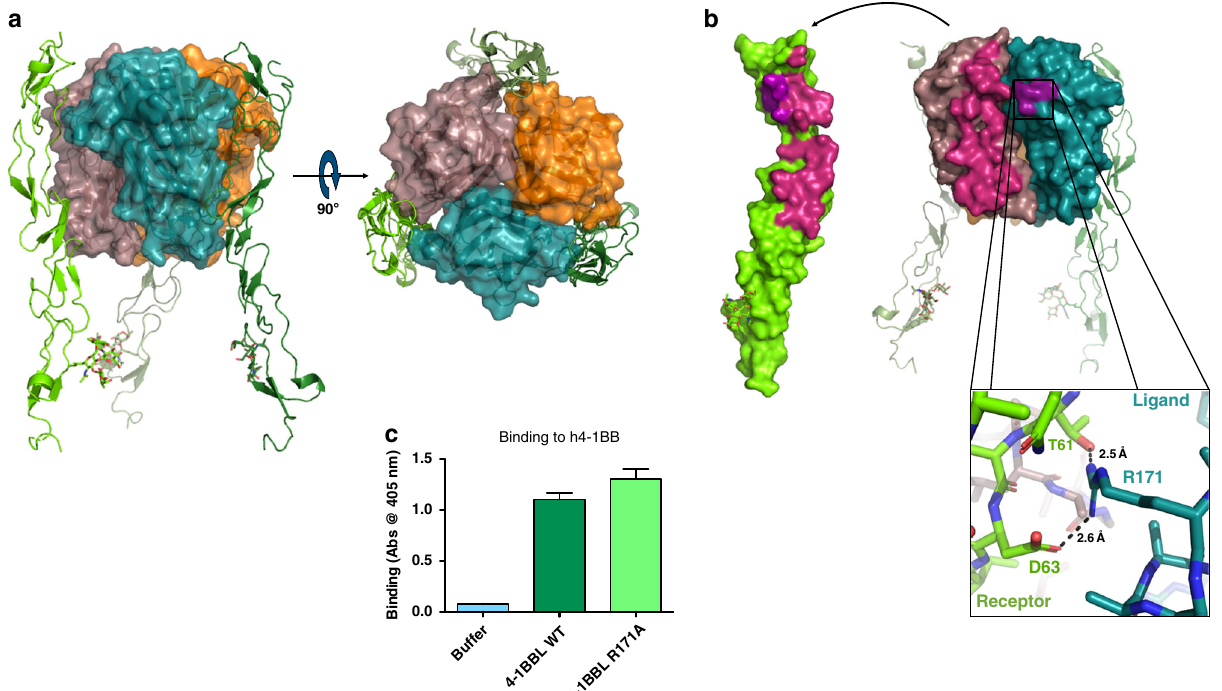
Fig. 1 Structure of the 4-1BB/4-1BBL complex. a Side view of the 4-1BB/4-1BBL complex with ligand protomers shown in surface representation and colored orange, deep teal, and dirty violet for chains A, B, and C, respectively. Receptor molecules are shown in cartoon representation and colored smudge, forest, and chartreuse for chains X, Y, and Z, respectively. A 90° rotation shows the receptors evenly spaced around the exterior of the trimeric ligand. b Open book view of the binding interface between 4-1BB receptor and ligand highlighting the interactions between receptor chain Z and ligand chains C and B. Interactions between chain Z and chain C are shown in magenta while interactions between chains Z and chain B are shown in purple. Inset shows zoom in of interaction between adjacent ligand protomer B (deep teal) and the receptor chain Z (chartreuse). Arg171 of the ligand forms a salt bridge with Thr61 and Asp63 of the receptor and is the primary interaction between the receptor and the adjacent ligand protomer. c Biotinylated wild type or R171A mutant h4-1BB ligand was incubated with captured wild type h4-1BB receptor before washing and detection with streptavidin-HRP. Data shown as mean with s.d. ( N = 3). Wild type (left, dark green) and R171A 4-1BBL (right, light green) bound to wild type 4-1BB at similar levels indicating that the R171 does not play